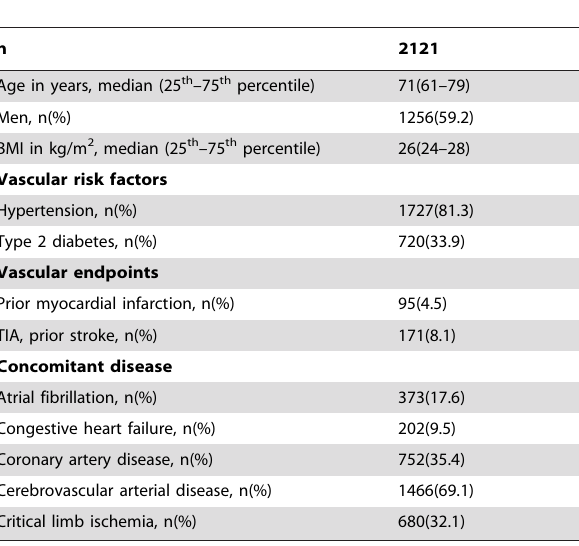
Table 1. Patients characteristics of all PAOD patients included in the